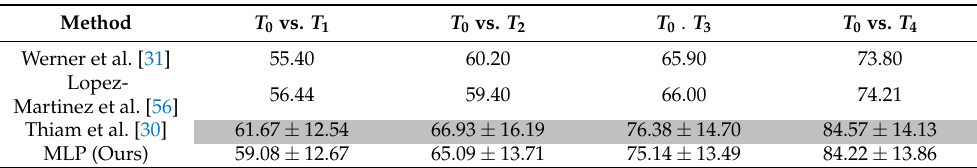
Table 7. LOSO accuracy performance comparison to early work on the EDA signal of the BVDB. The best performing approach is highlighted in